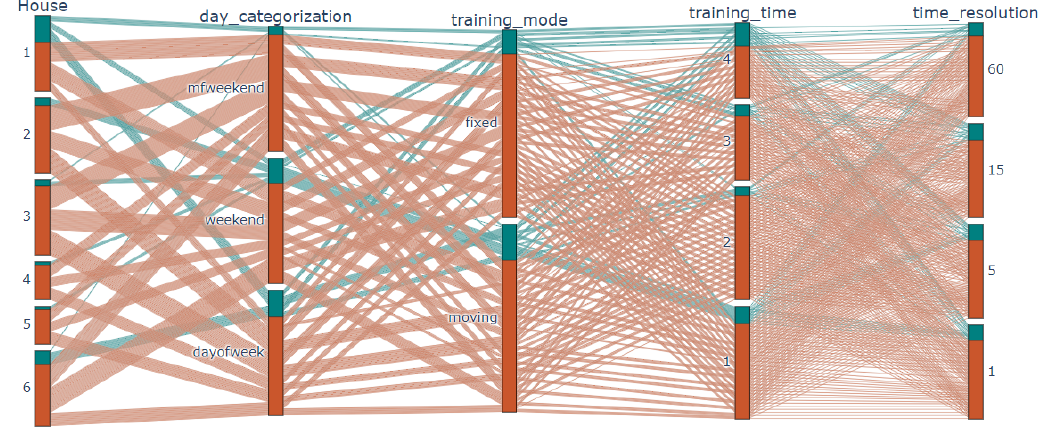
Figure 8. Parallel category plot of occupancy